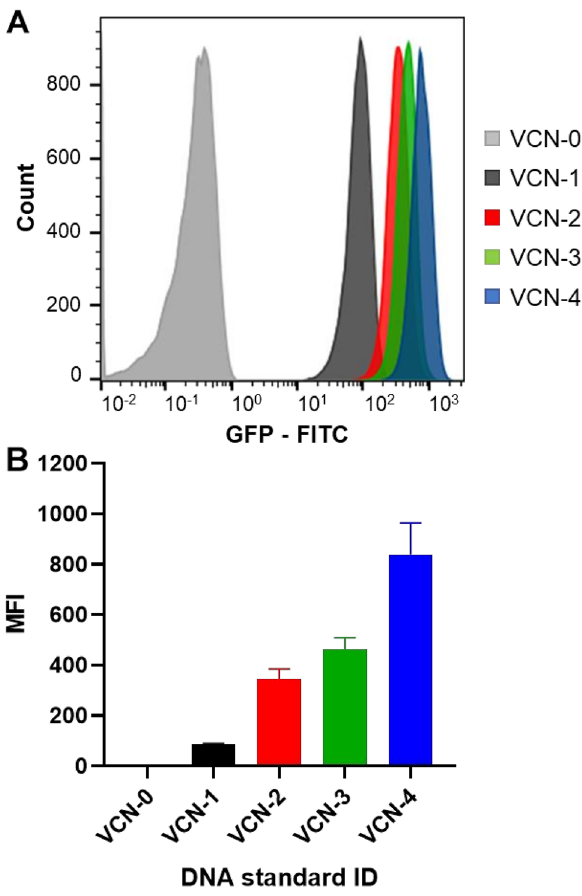
Figure 4. GFP mean fluorescence intensity expression correlates with vector copy number. Developed clonal Jurkat cell lines with a defined number of copies of integrated vector were evaluated by flow cytometry to measure expression of GFP, which is encoded by the integrated vector sequence under the control of a constitutive promoter. ( A ) Representative histogram plot showing increased expression of GFP observed in engineered Jurkat cell lines with higher VCN per cell. ( B ) GFP mean fluorescence intensity (MFI) from three independent measurements is consistent with the genomic vector copy number for each evaluated cell line. Error bars represent standard deviations for the means of the data